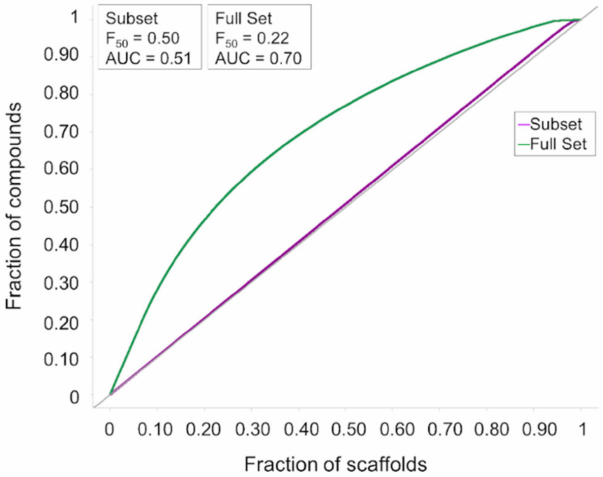
Figure 2. Cyclic system retrieval (CSR) curves of the subset and full set. Related AUC and F 50 values are also